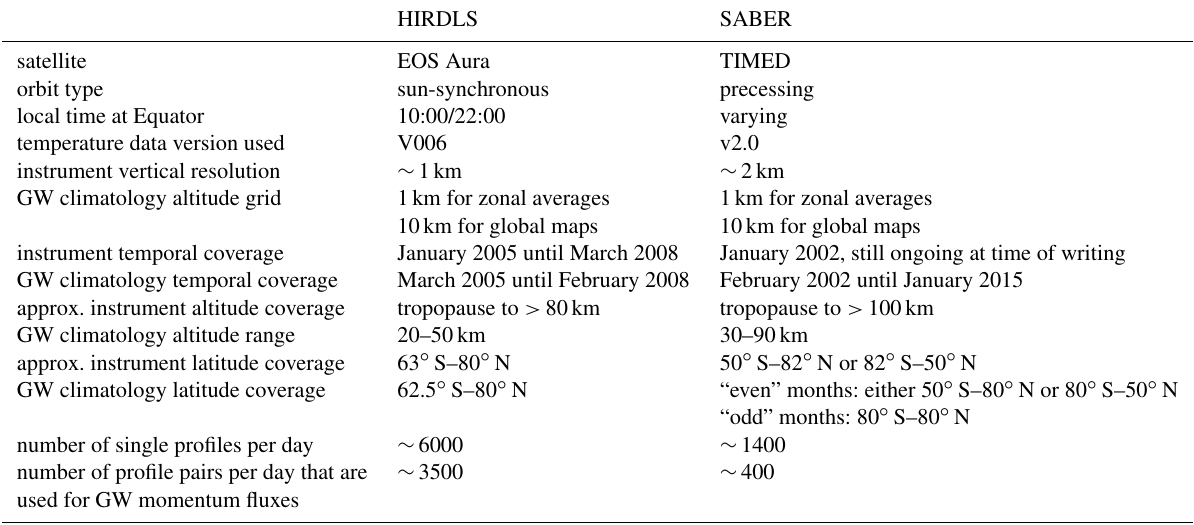
Table 1. Characteristics of the HIRDLS and SABER instruments and data sets. Also given is the coverage used for the GRACILE gravity wave (GW) climatology.